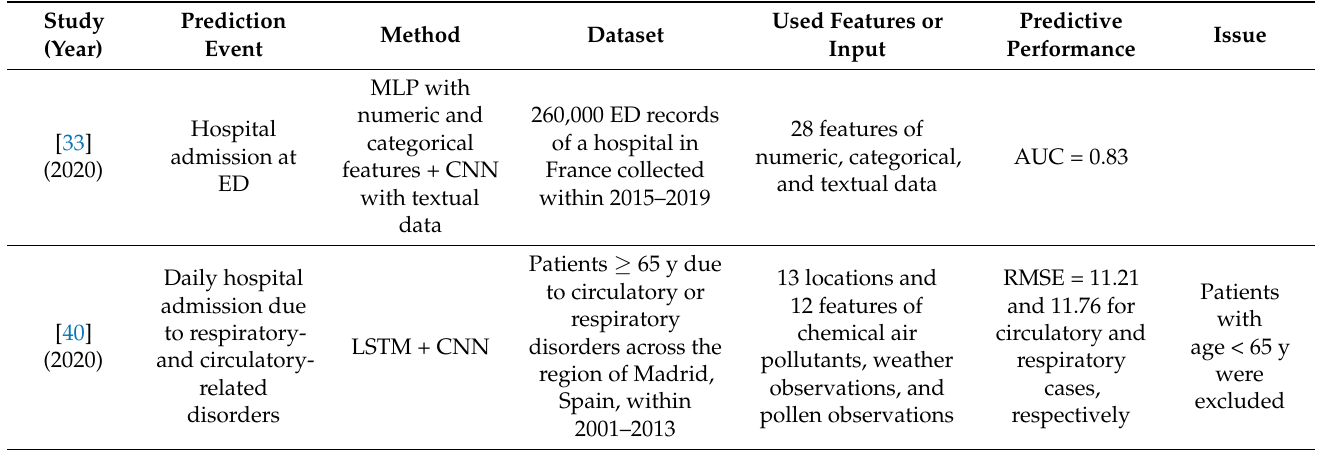
Table 1. Recent AI models for predicting associated events of hospital